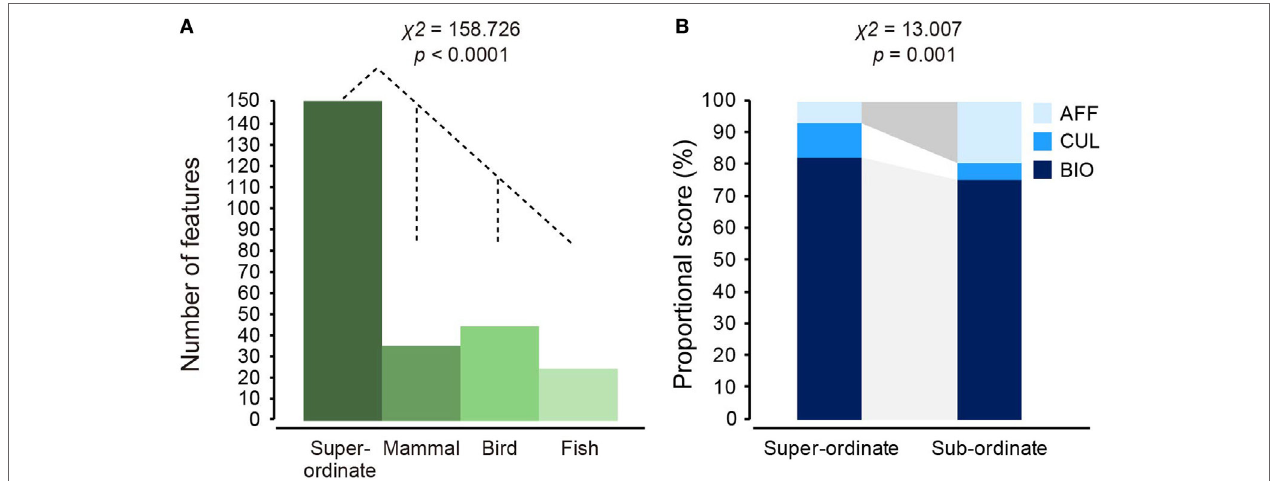
FigUre 6 | Quantitative and qualitative examinations of features that fit significantly to sigmoid-shaped binary response functions for the super-ordinate and sub-ordinate classifications. Number of features in the super-ordinate and three sub-ordinate categories were compared with a χ 2 test (a) . The super-ordinate category was related to a larger number of features than the sub-ordinate (mammal, bird, and fish) classes. Ratios of biological (STR, structural; ECO, ecological; DIS, distributional; EVO, evolutional), cultural, and affective (AFF) features in the super-ordinate (clustering level 1 + 2) and overall sub-ordinate categories were compared. Follow-up χ 2 tests using the biological and AFF features demonstrated that the sub-ordinate classes had a higher ratio of the AFF feature than the super-ordinate classes, as represented by the dark gray area (B)